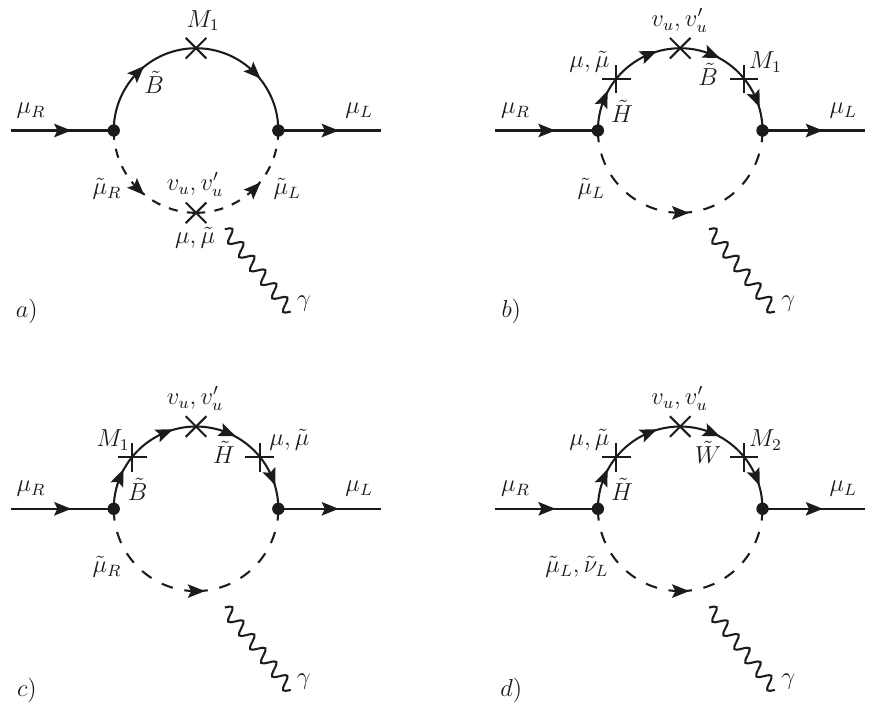
Figure 1 . The leading 1-loop contributions to the anomalous magnetic moment of the muon. The external photon has to be attached in all possible ways to the loops. Diagrams a), b), and c) involve binos, while diagram d) involves winos. The threshold corrections to the muon mass correspond to analogous diagrams without the external